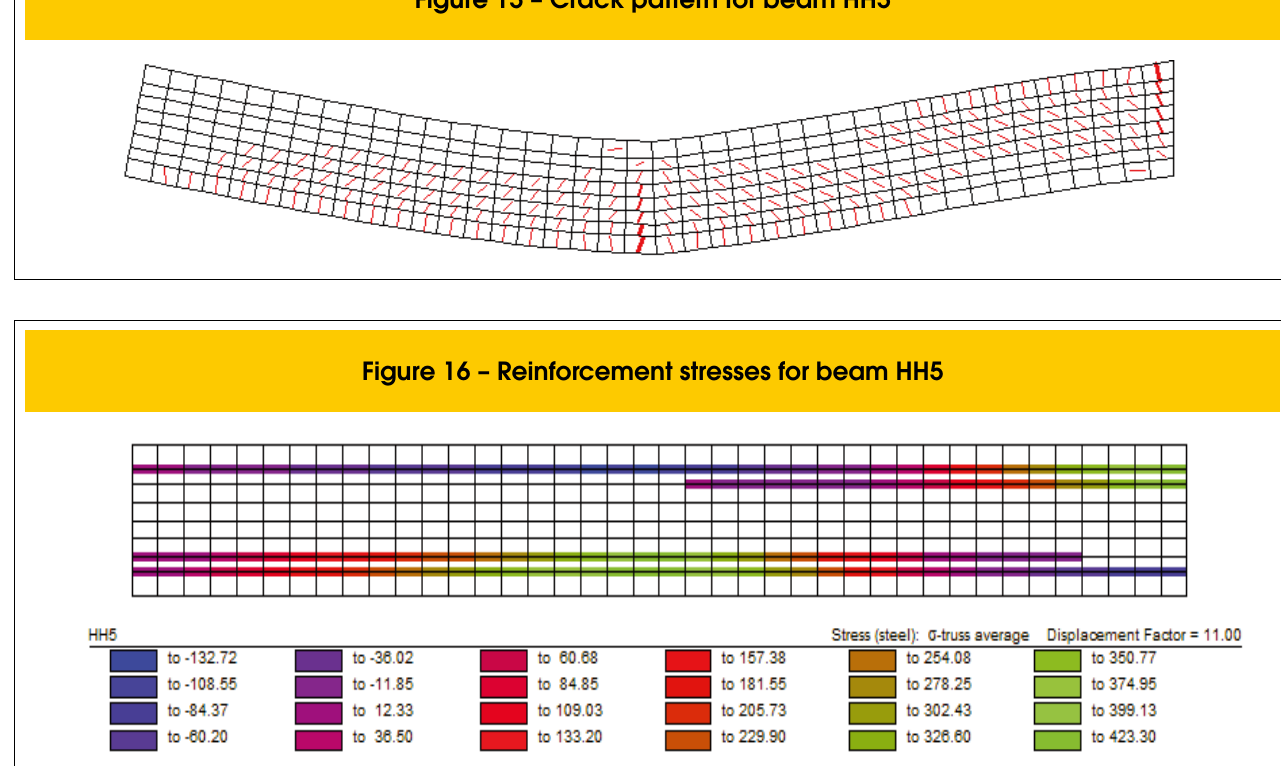
Figure 15 – Crack pattern for beam HH5